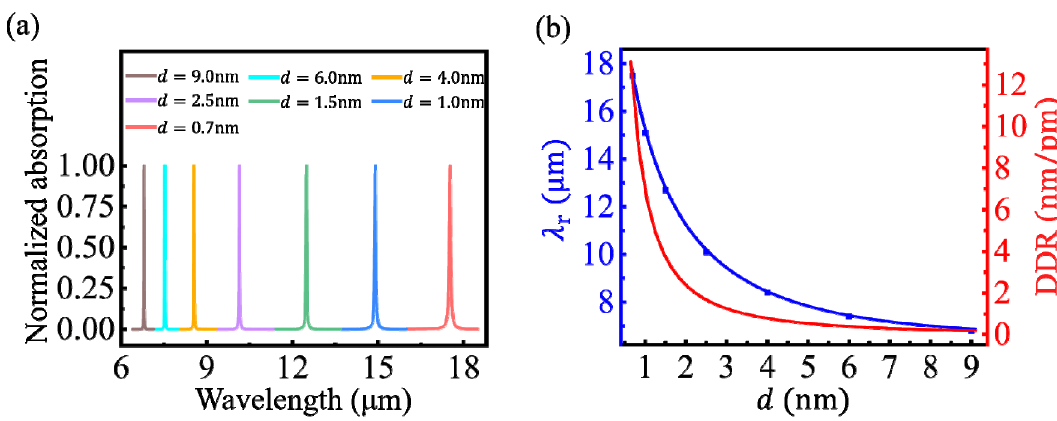
Figure 3. ( a ) Normalized absorption spectrums of the CGS under different spacer thicknesses. ( b ) Dependences of the LSPR wavelength (blue line) and the dimensional differential resolution (DDR; red line), respectively, on the spacer thickness for µ c = 0.5 eV, L = 40 nm, and n 3 = 1.5. The blue rectangles are the numerical results obtained using COMSOL Multiphysics (this scheme is also used in Figures 4–6).